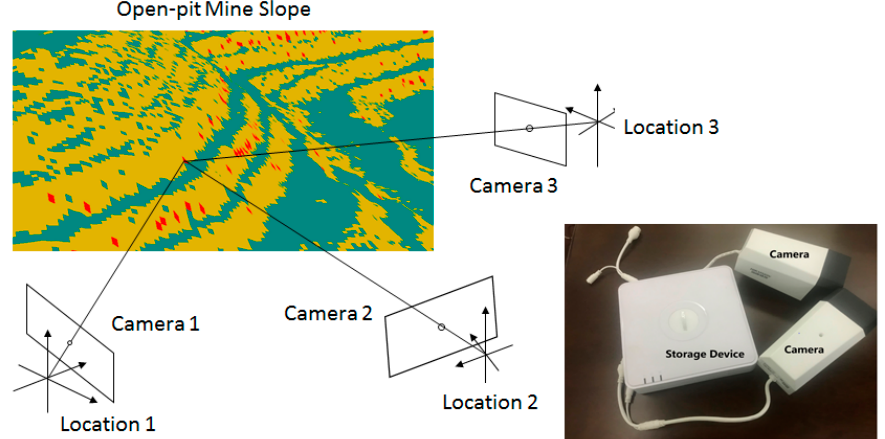
Figure 1. Sketch deployment diagram for open-pit mine slope monitoring. At the top left, the blue area represents the bench work surface, the yellow area represents the bench slope and the red area represents the risk exceeding the threshold.